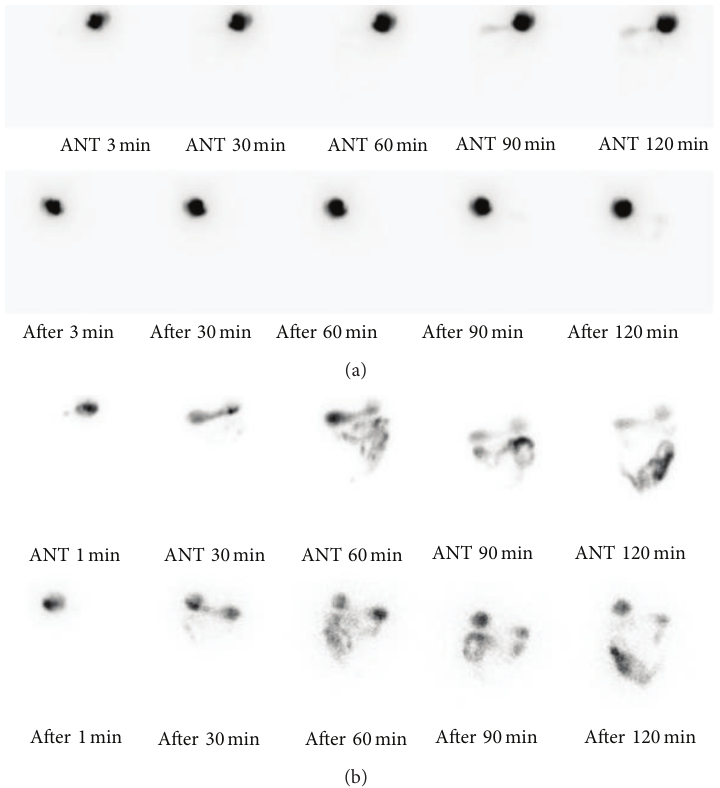
Figure 2: (a) Gastric emptying scan reveals delayed gastric emptying time with an almost flat time-activity curve. A large amount of contrast material remains in the 2-hour delayed image, suggesting severe gastric hypomotility. (b) Gastric emptying scan reveals delayed gastric emptying time, suggesting normal gastric